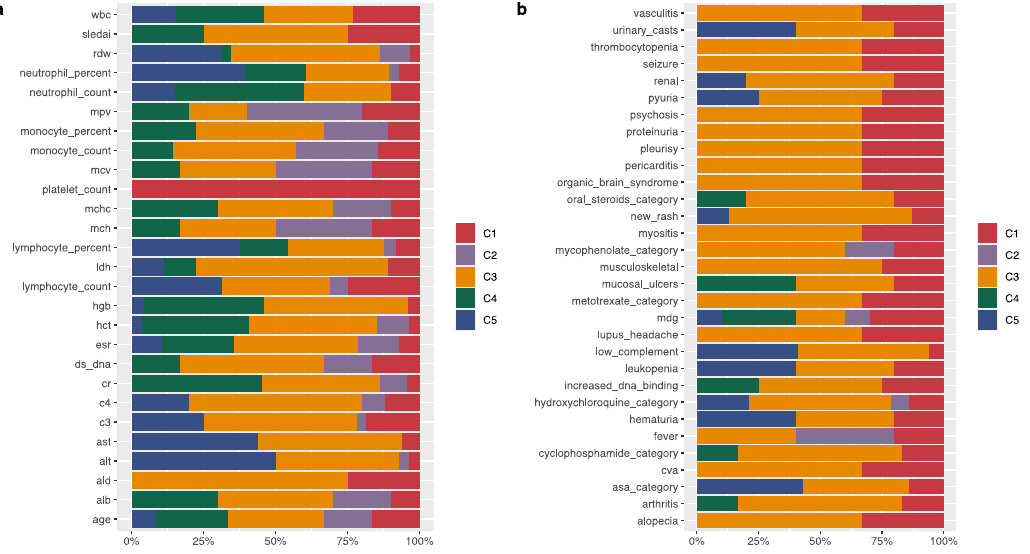
Figure 4. Fraction of rules per cluster significantly associated with ( a ) continuous and ( b ) categorical phenotypes. See Supplementary Table S3 online, for a list of clinical variables and phenotypes